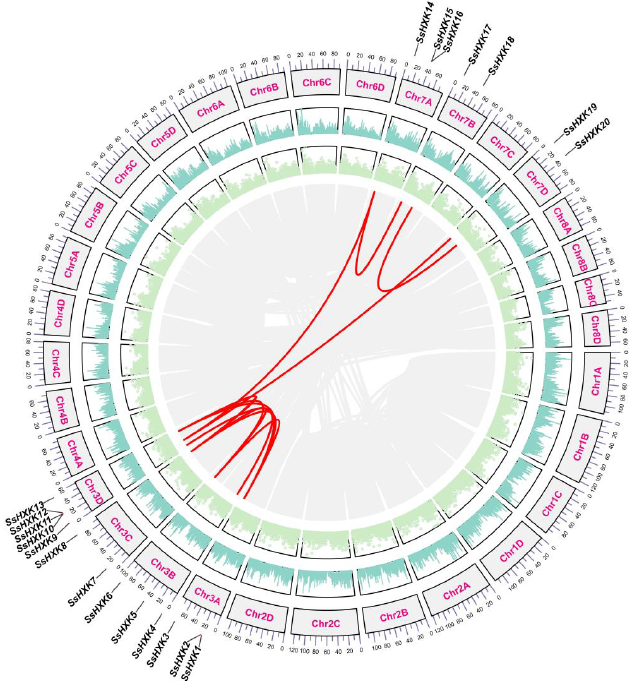
Figure 3. Schematic representations highlighting the interchromosomal relationships of the SsHXK genes. Gray lines indicate all syntenic blocks in the sugarcane genome, and the red lines indicate duplicated HXK gene pairs.